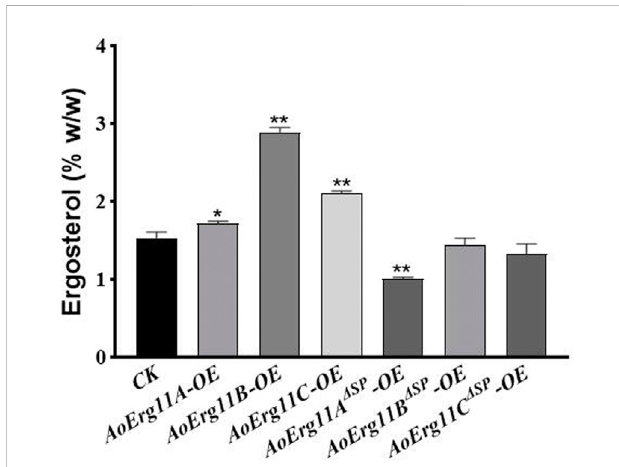
FIGURE 6 Ergosterol contents of AoErg11s and AoErg11 Δ SP s overexpression strains. The control and transformants werecultured in DPY for 3 days at 30 ° C and collected to determine the content of ergosterol. Values represent the mean ± SD of three independent experiments. Statisticalanalyseswereperformedby t -testofGraphPad(*, p < 0.05;**, p < 0.01). The ergosterol content of each experimental group was compared with